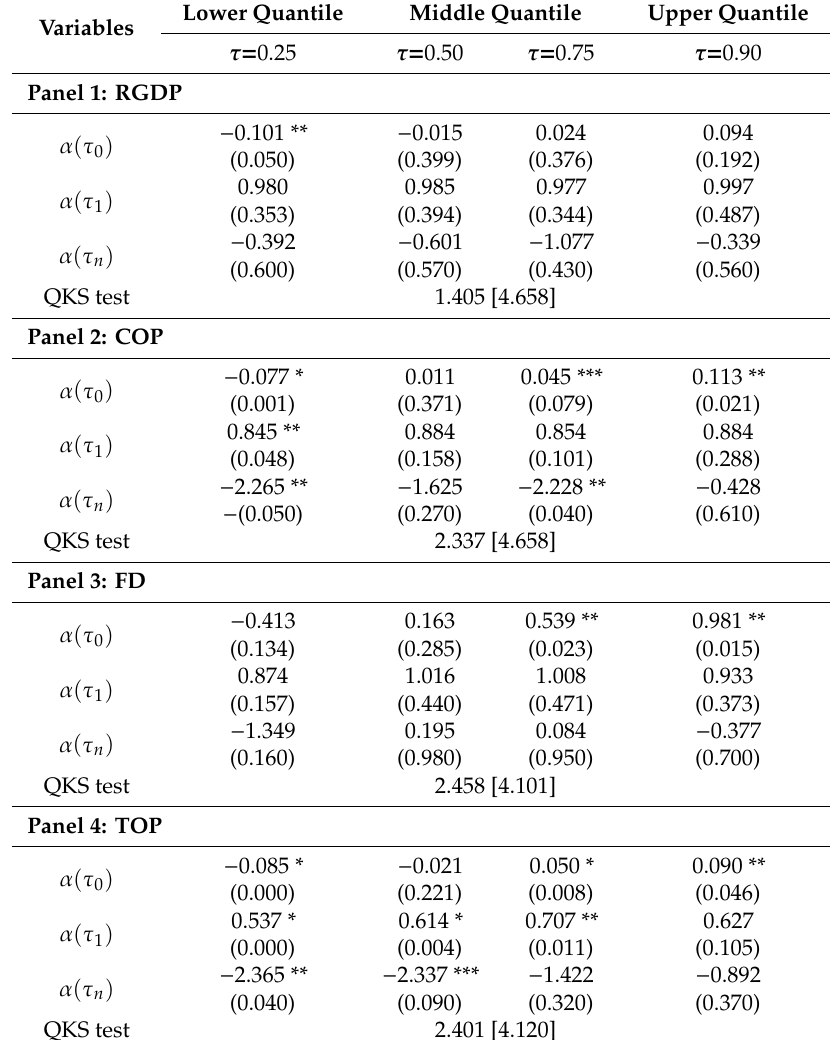
Table 5. Quantile unit root test